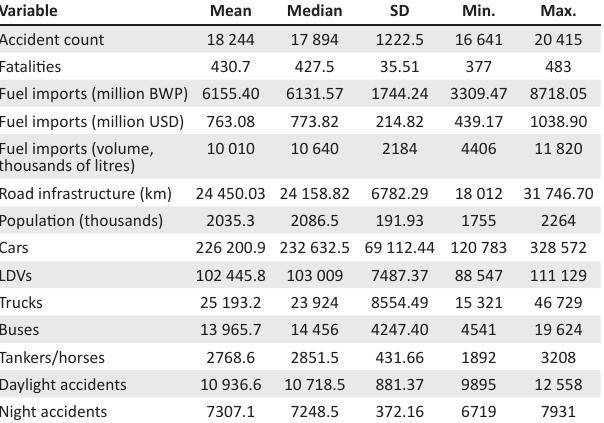
TABLE 1: Botswana road traffic accident summary statistics (2008–2017).